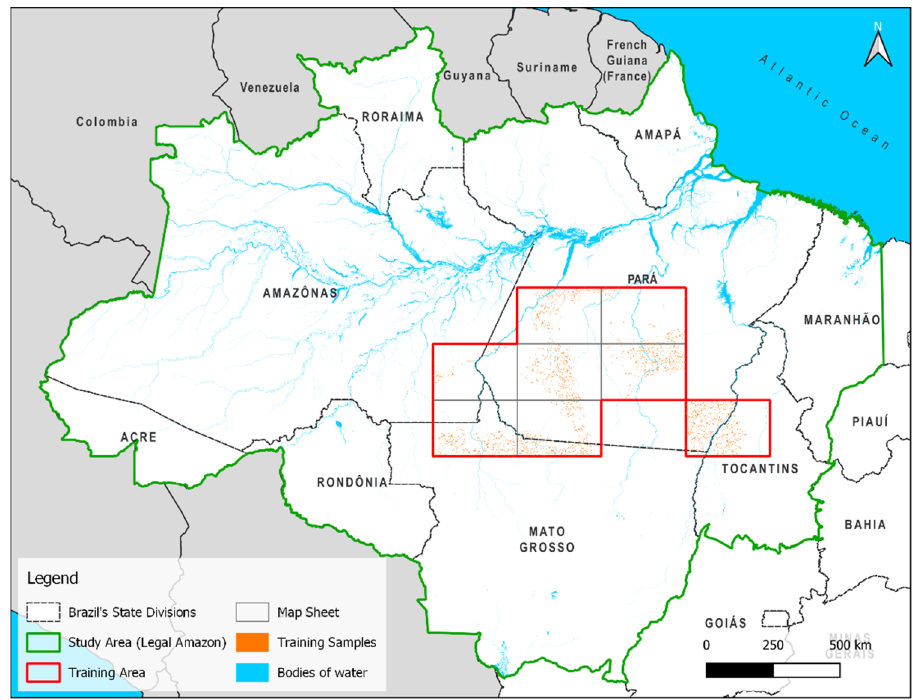
Figure 2. The study area covers the entire Brazilian Amazon (green). Training and validation chips (orange) were selected in eight International Millionth Map of the World map sheets (red; SB-21-X, SB-21-Y, SB-21-Z, SB-22-V, SC-21-V, SC-21-X, and SC-22-X).